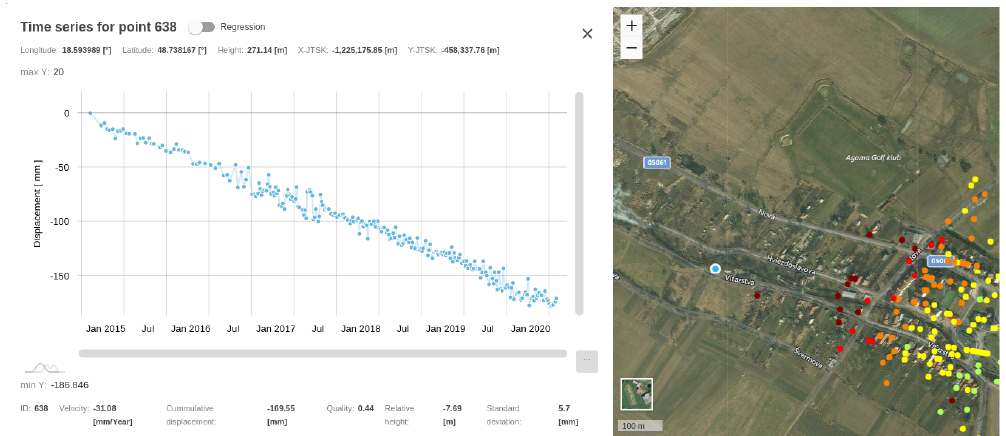
Figure 14. Displacement time series over retained low-coherence point inside active mining area of Kos municipality.